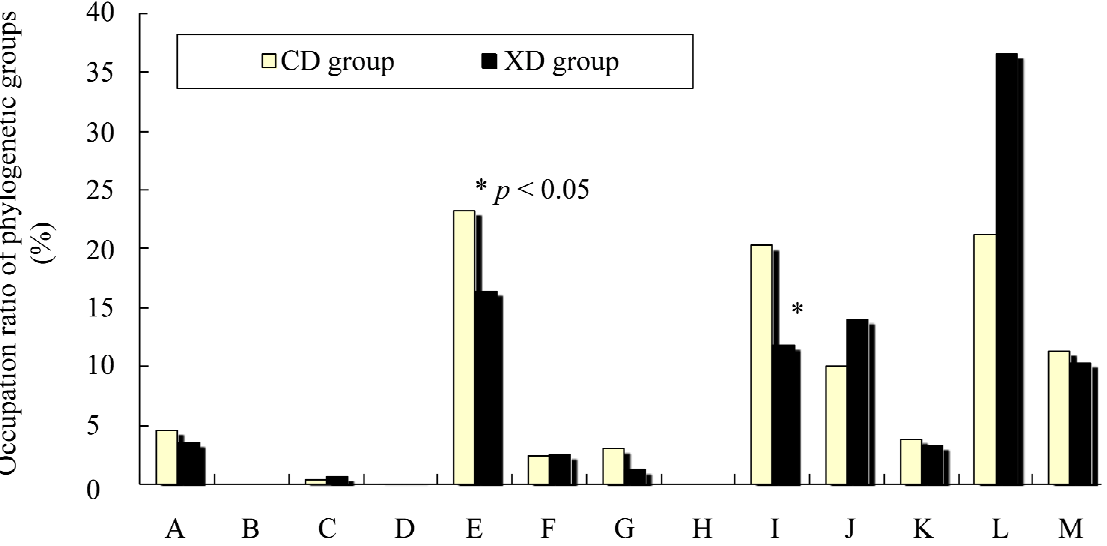
Figure 7. Composition of cecal intestinal microbiota of mice in the CD and XD groups. OTUs (operational taxonomic units), which correspond to either T-RFs (terminal restriction fragments) or T-RF clusters, detected by T-RFLP (terminal restriction fragment length polymorphism) analysis. Values are means ± SE ( n = 7). * Significantly different ( p < 0.05) from the CD group. Data were analyzed using the Student’s t -test analysis. Letters correspond to the following phylogenetic bacterial groups: ( A ) Bacteroides , Clostridium cluster IV (OTUs 370); ( B ) Clostridium cluster IV (OTUs 168, 749); ( C ) Clostridium cluster IX, Megamonas (OTUs 110); ( D ) Clostridium cluster XI (OTUs 338); ( E )